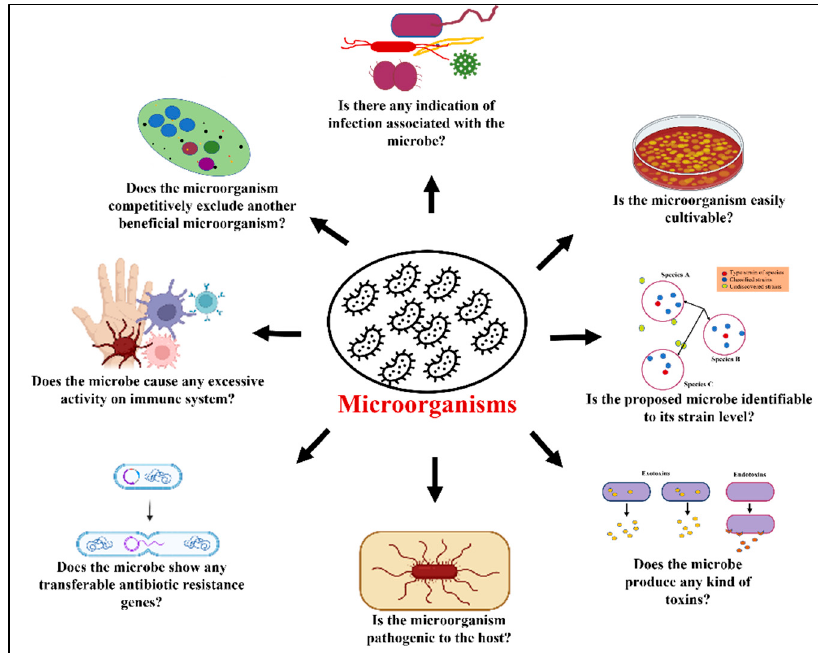
Figure 2. Criteria for evaluation of potential probiotics in animal feeding.